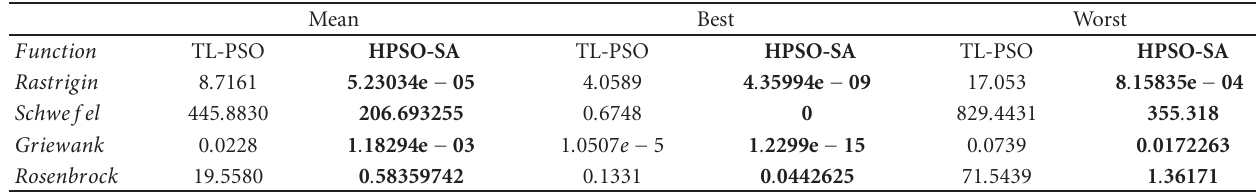
Table 2: Comparison of hybrid HPSO-SA algorithm with TL-PSO approach [8].